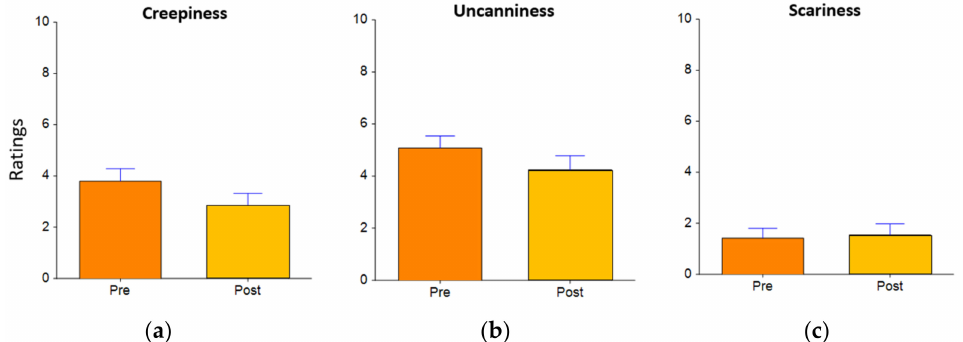
Figure 7. Self-reported ratings of questionnaires for “negative” characteristics ( a ) creepiness; ( b ) uncan- niness, and ( c ) scariness) towards the robot pre-interaction (in orange) and post-interaction (in yellow).